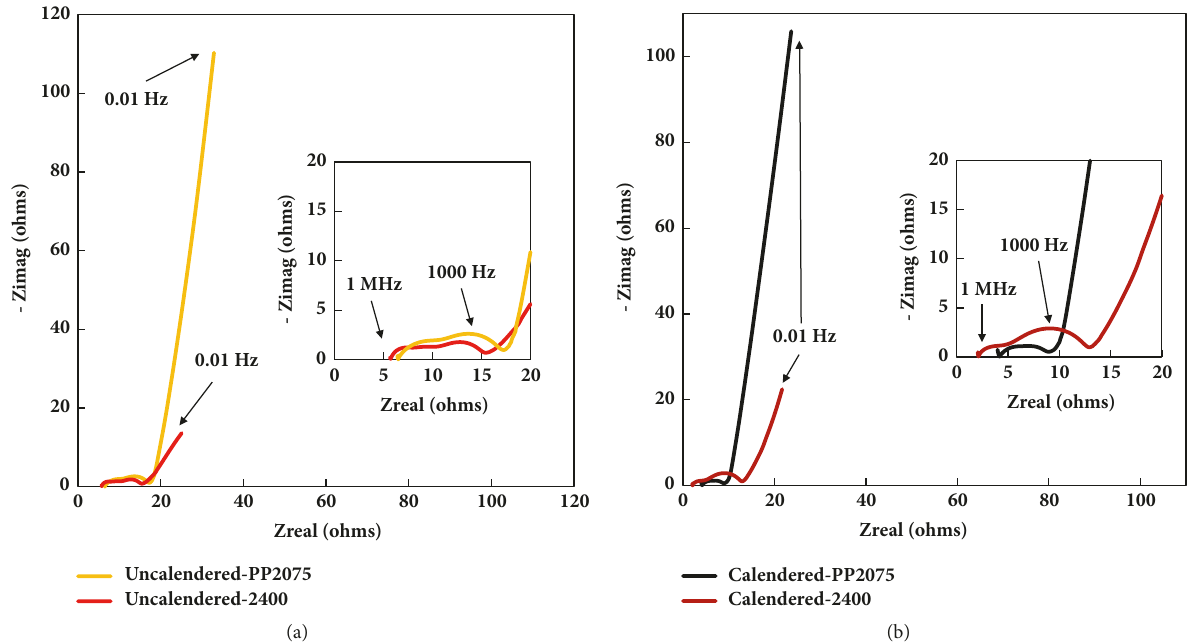
Figure 7: Measured EIS data for calendered and uncalendered electrodes for monolayer separators: (a) uncalendered electrodes using 2400 and PP2075 separators; (b) calendered electrodes using 2400 and PP2075 separators. Table 1: Comparison of the separators based on thickness, porosity, and specific